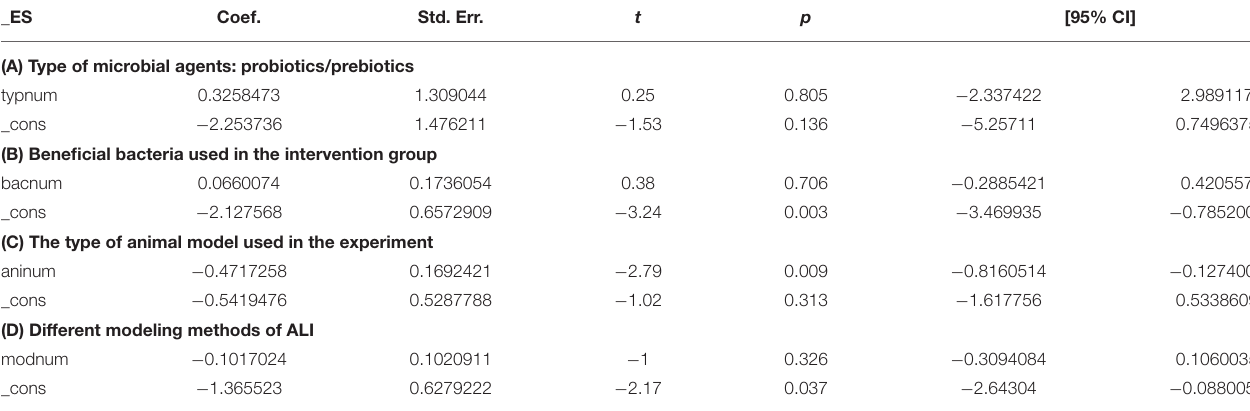
TABLE 3 | Univariate meta-regression of AST with four major variables. _ES Coef. Std. Err.